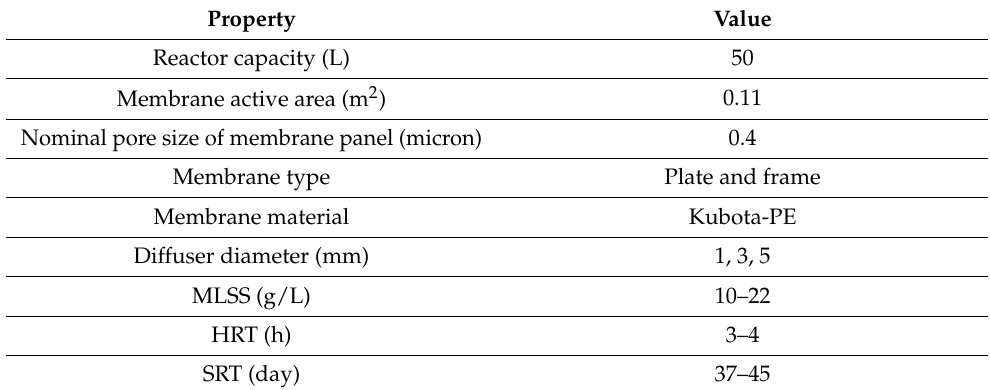
Figure 1. Flow diagram of pilot-scale MBR unit system, which utilizes main WWTP MBR as feed water source via feed pump, the pilot system used three Kubota plate type 0.4 µm membranes, aeration was achieved via three mini-blowers, excess sludge was taken from the reactor to WWTP MBR via recycle pump. Air diffusers with 1, 5, and 3 mm of perforated hole diameters (( a ) : 1 mm, ( b ): 5 mm and ( c ): 3 mm). Table 2. Properties of the pilot MBR test unit .